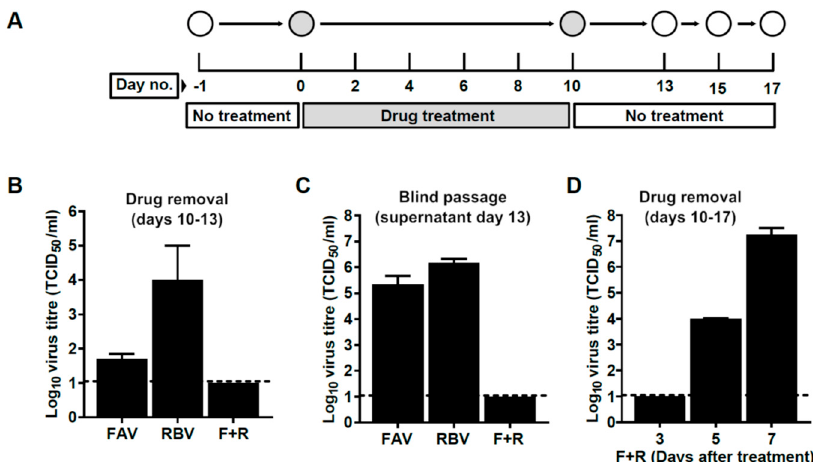
Figure 6. USUV infectivity re-emerges in the supernatant of persistently-infected cells after drug withdrawal. ( A ) Experimental procedure. Cells were treated for 10 days in the presence of FAV, RBV, or a combination of both (F + R) at a concentration of 2000 µ M for each drug ( n = 1). After 10 days, drugs were removed and cells cultured for 3 (FAV and RBV) or 7 additional days (F + R). ( B ) Viral infectivity (TCID 50 / mL) detected in the supernatant of cells after 10-day drug treatment followed by 3 days in the absence of drugs. ( C ) Viral infectivity recovered after three serial passages of cellular supernatants collected in B. In each blind infection, 100 µ L of supernatant from the previous passage was used to infect a new monolayer of Vero cells. After adsorption for 1 hour, fresh media was added and cells were incubated for 24 additional hours at 37 ◦ C. ( D ) Viral infectivity ( ± SEM) in the supernatant of S cells treated with F + R for 10 days followed by absence of treatment for 3, 5, and 7 days. (B–D) A dashed line represents the limit of detection.